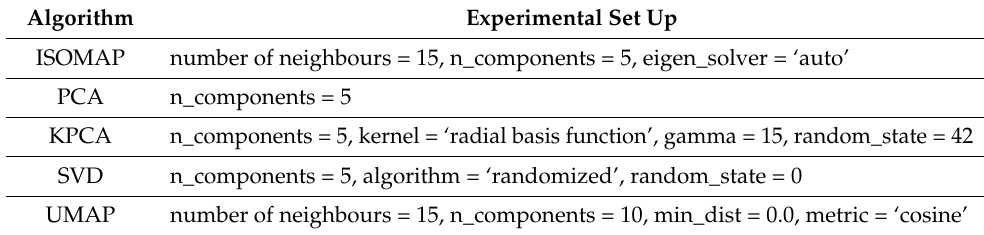
Table 1. Dimensionality reduction algorithms.